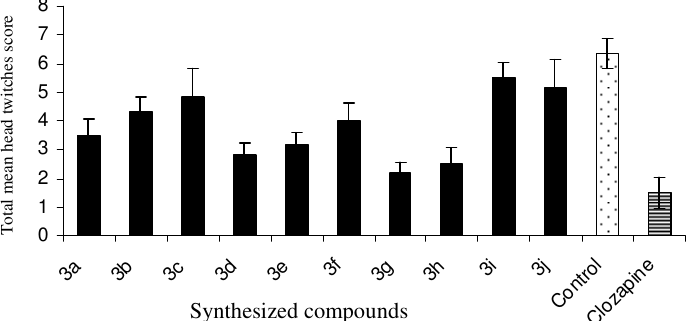
Figure 2. The effect of synthesized compounds ( 3a-j ) on the 5-HTP induced head twitches behavior. ( Each column represents the mean ±SEM of total head twitches score for group of six mice assessed at 10 min intervals for 30 min, starting 20 after the 5-HTP treatment. A score of 8 is the maximum possible. All values statistically significant with respect to control at p<0.05)